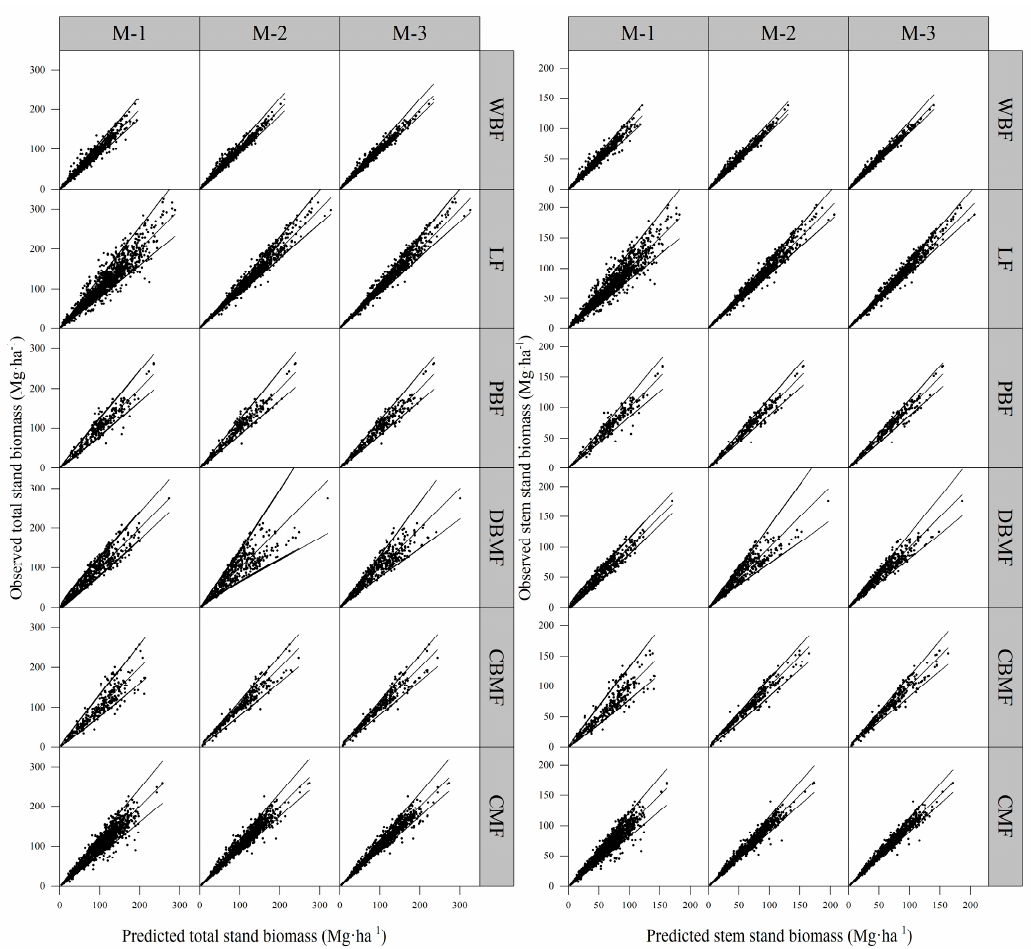
Figure 3. Multipanel display of observed total and stem biomass for each forest type plotted against their predicted values from M-1, M-2 and M-3. The diagonal line of unity is shown with the 90% upper and lower confidence limits of prediction error in each